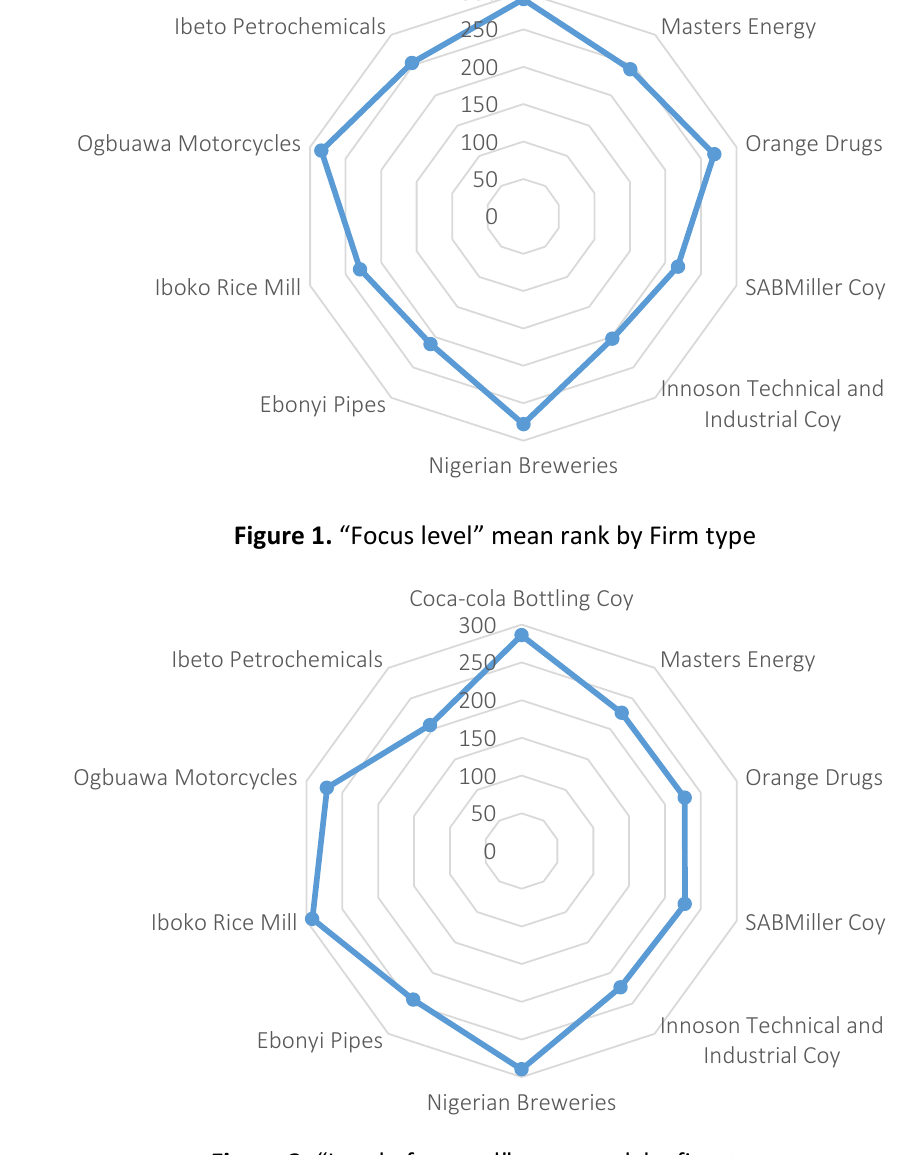
Figure 2. “Level of control” mean rank by firm Table 3. Kruskal-Wallis H result on group difference